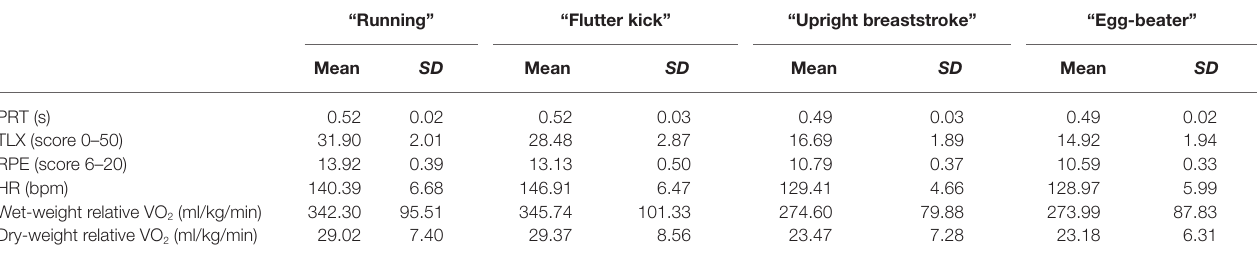
TABLE 3 | Descriptive